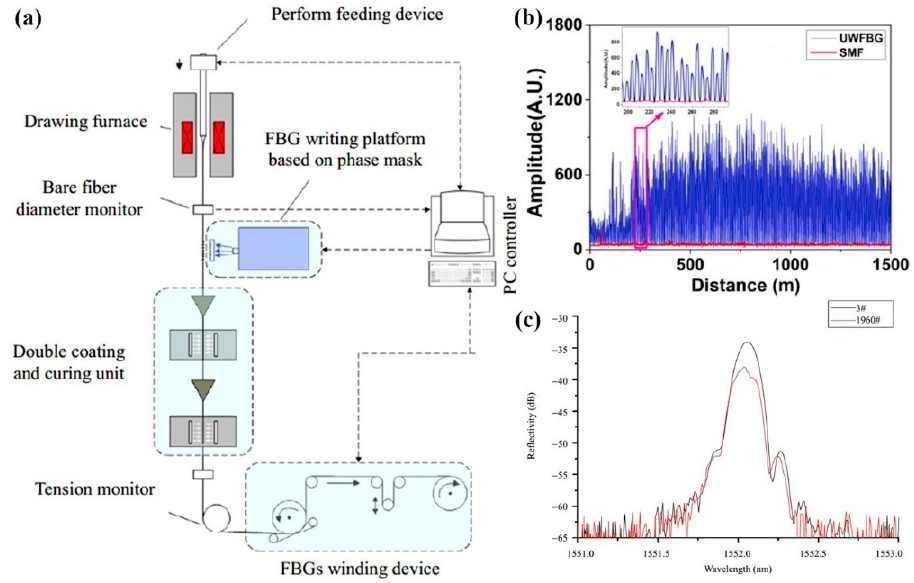
Figure 8. Typical UWFBG preparation method: ( a ) online UWFBG preparation system [46]; ( b ) OTDR measurement results of the UWFBG array [47]; ( c ) reflection spectrum of UWFBG [46].